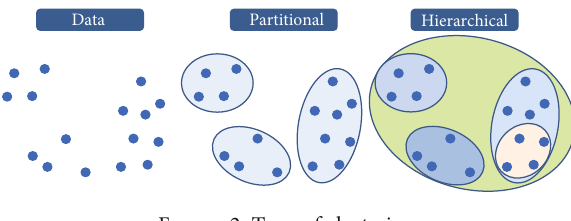
Figure 2: Type of clustering.